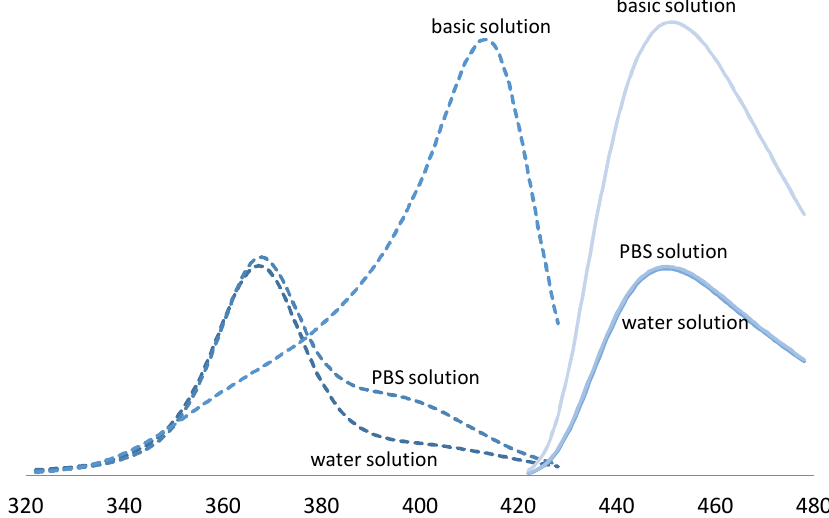
Figure 3. Fluorescence properties of coumarin-gelatin RFG dosimeter, excitation (dashed-lines) and emission (solid-lines) spectra for solutions of 7% gelatin with 0.9 mM C3CA and 0.1 mM umbelliferone. Curves are labeled in the graph. X -axis represents wavelength of emitted and collected light, Y -axis is not shown but represents an arbitrary unit of light intensity.